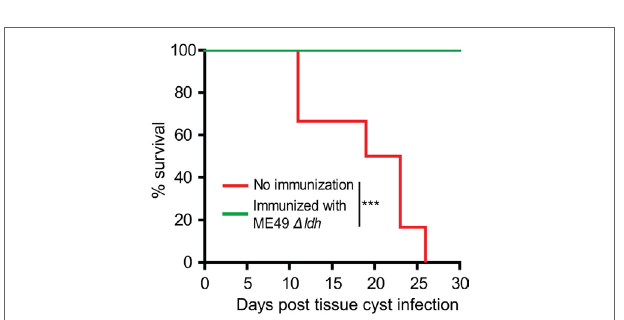
FigUre 3 | Δ ldh mutant vaccination protected mice from Toxoplasma gondii cysts infection. ICR mice were pre-immunized with ME49 Δ ldh as in Figure 2 , 30 days post-immunization they were challenged with 50 fresh brain cysts of the ME49 strain and their survival was monitored for another 30 days ( n = 10 mice for each strain). Non-immunized mice were included as control. *** p < 0.001, Gehan–Breslow–Wilcoxon test.